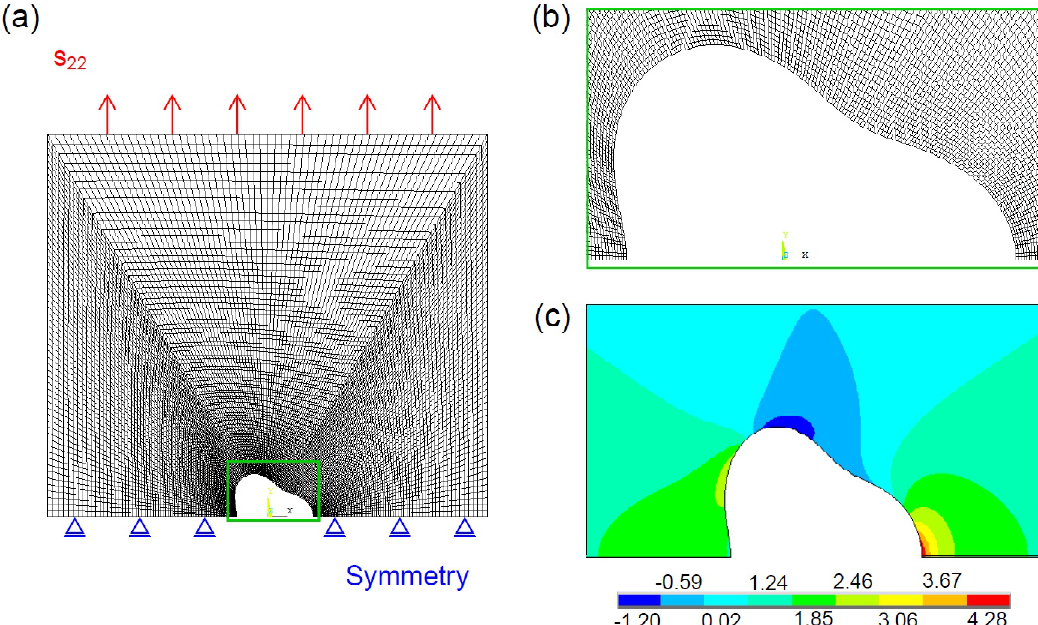
Fig. 5. (a) Finite element model of an elastic body with a concave rounded triangular pore (  =0.2); the symmetry of the problem is taken into account. (b) A fragment of the finite element model near the pore. (c) Distribution of the stress component 